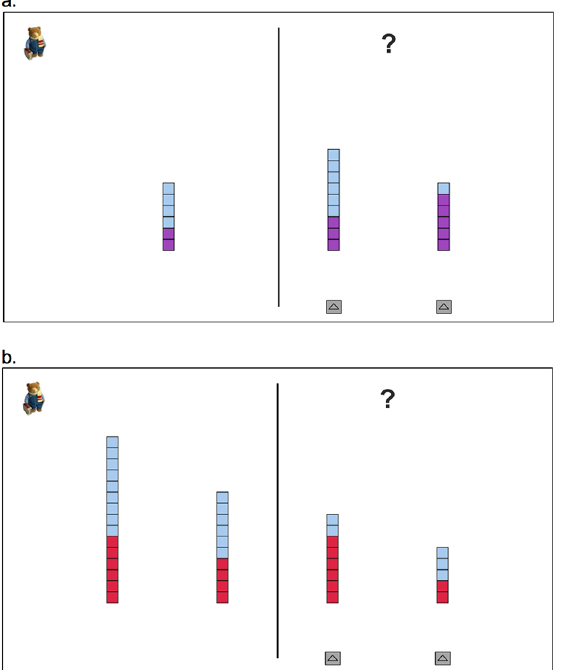
Figure 1. Example trial from one-exemplar condition (a). Example trial from two-exemplars condition (b). Adapted with permission from “Development of Proportional Reasoning: Where Young Children Go Wrong,” by T. W. Boyer, S. C. Levine, and J. Huttenlocher, 2008, Developmental Psychology , 44 (5), p. 1478. Copyright 2008 by the American Psychological